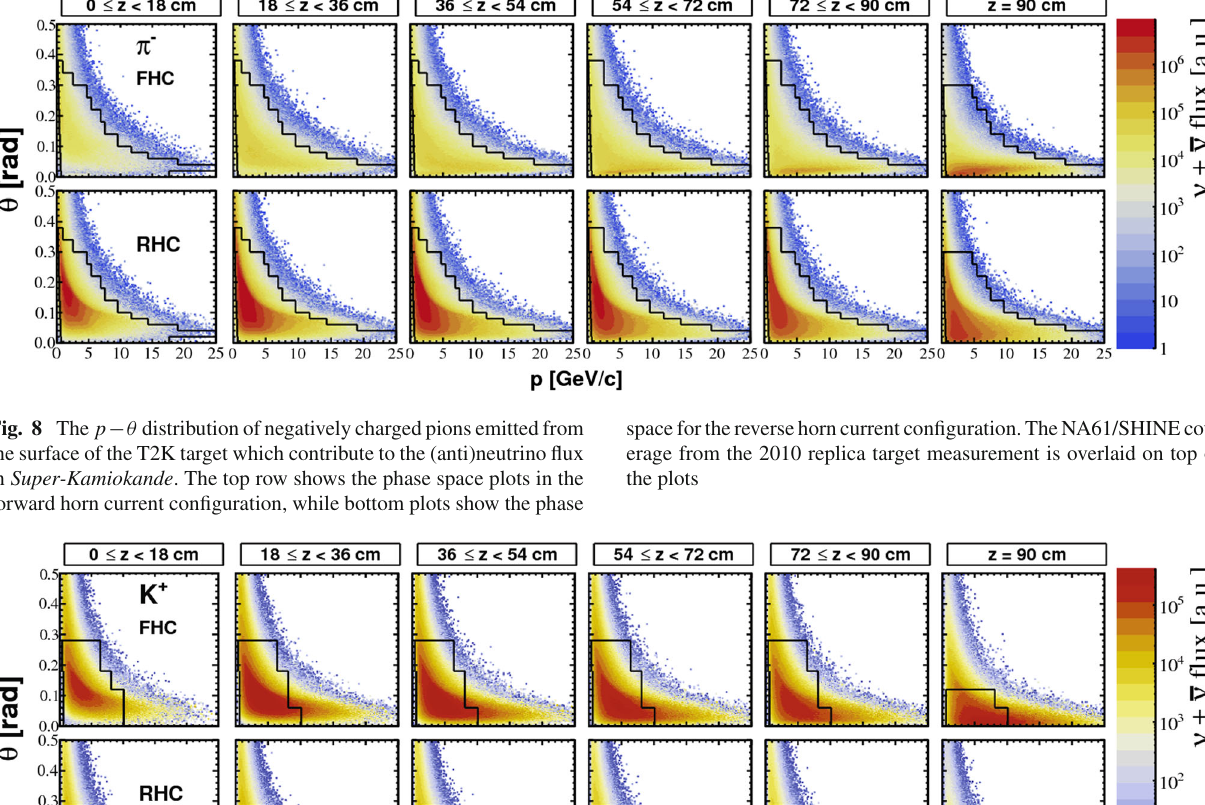
spaceforthereversehorncurrentconfiguration.TheNA61/SHINEcov- erage from the 2010 replica target measurement is overlaid on top of the plots